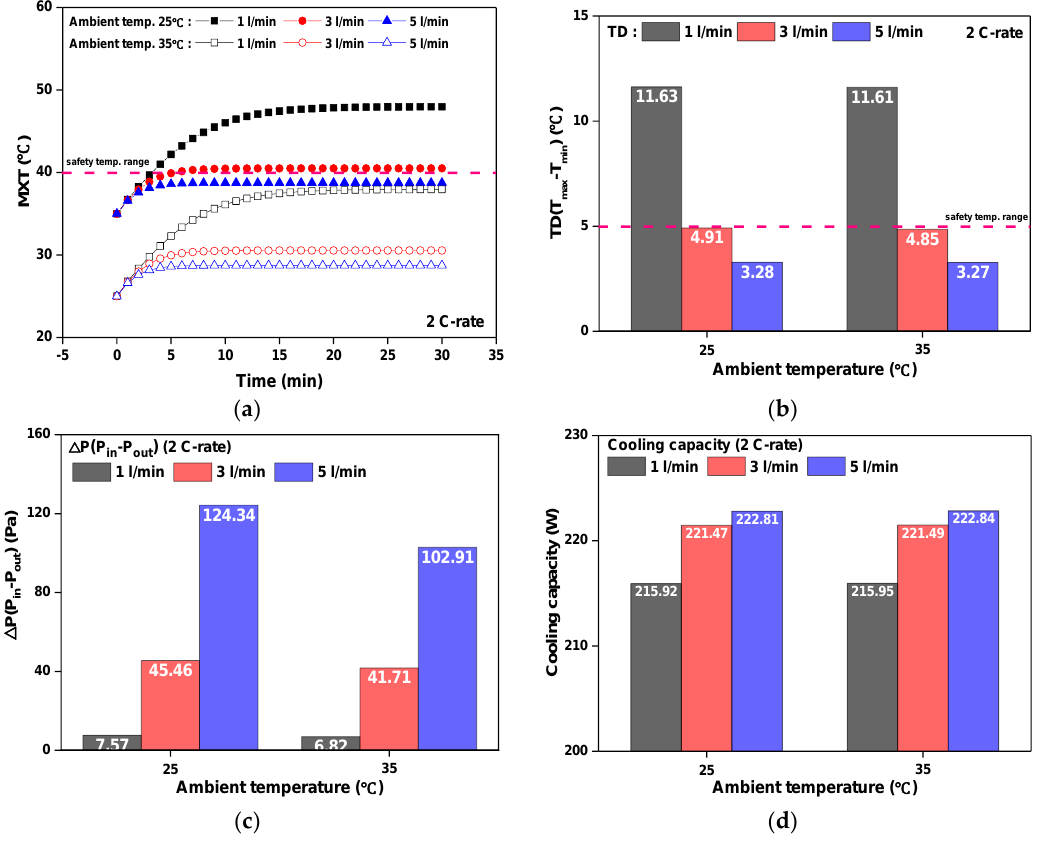
Figure 9. Comparison of cooling performance according to flow rate under 25 °C and 35 °C outdoor air conditions: ( a ) MXT of the battery according to time; ( b ) TD of the battery according to time; ( c ) Pressure drop for different ambient temperatures; ( d ) Cooling capacity for different ambient temperatures.